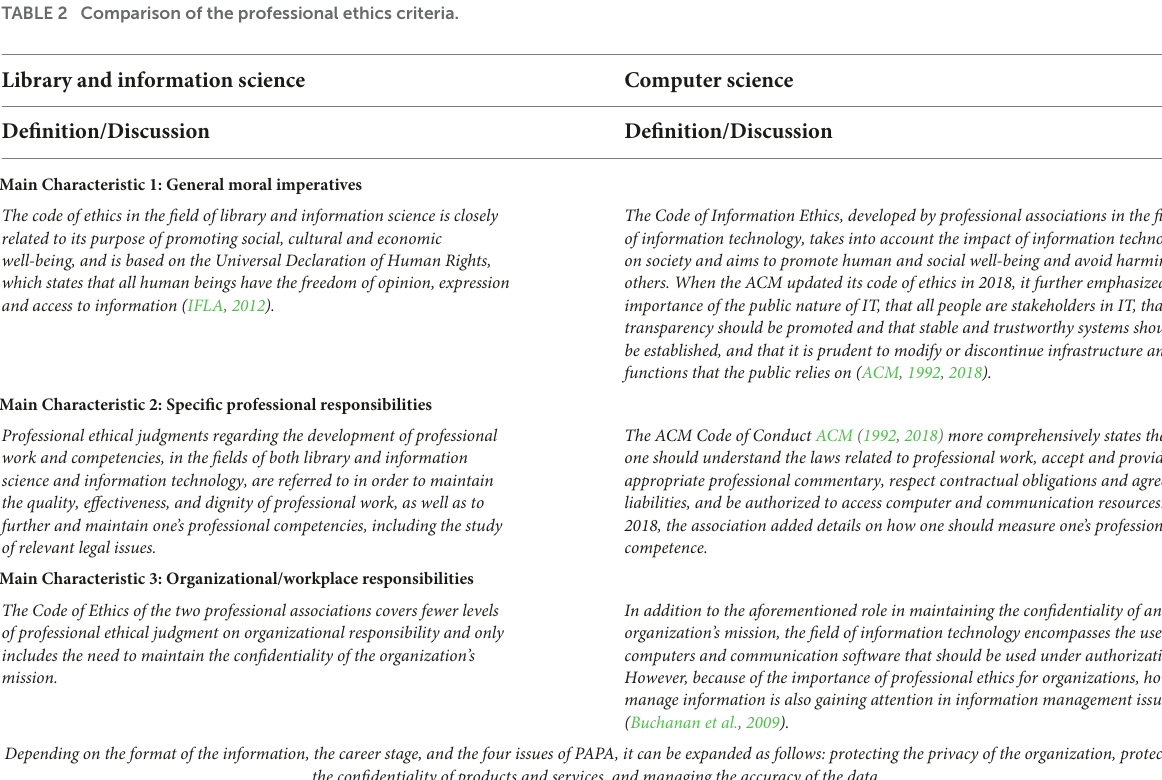
TABLE 2 Comparison of the professional ethics